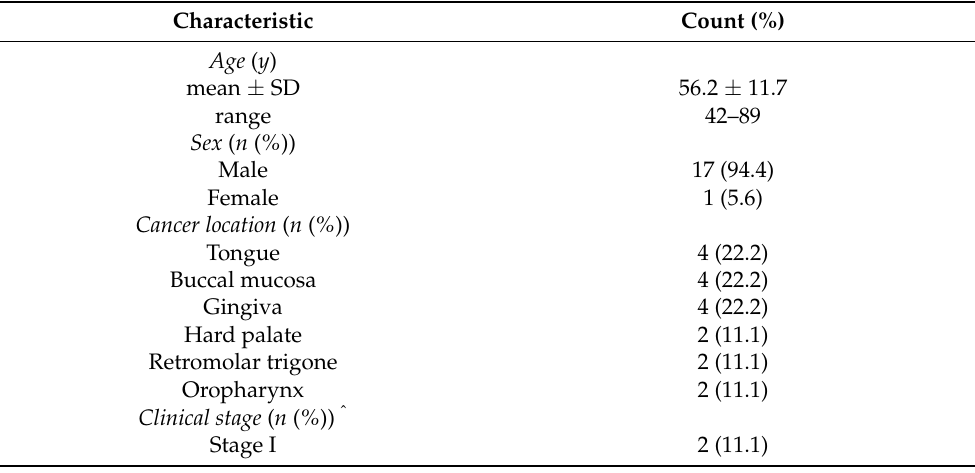
Table 1. Baseline sociodemographic variables of OSCC patients ( n =